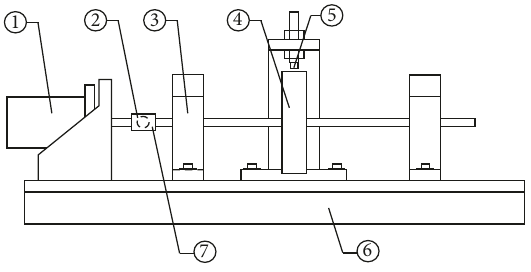
Figure 9: ZT-3 multifunction rotor simulation test bench.